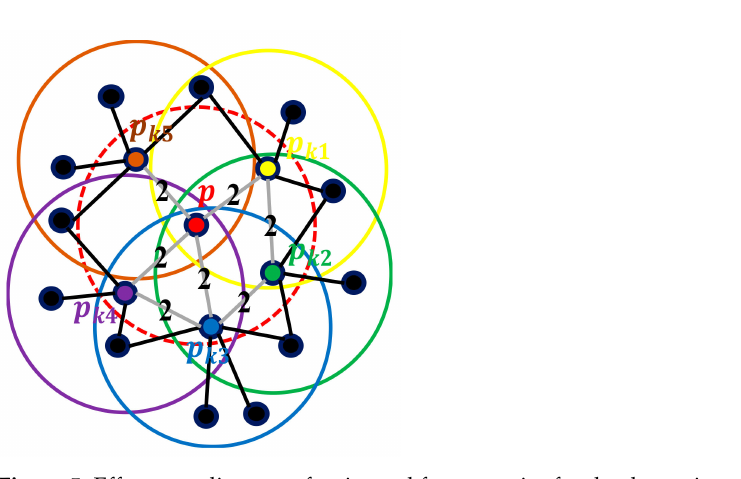
Figure 5. Effect area diagram of estimated feature point for the dynamic workpiece using